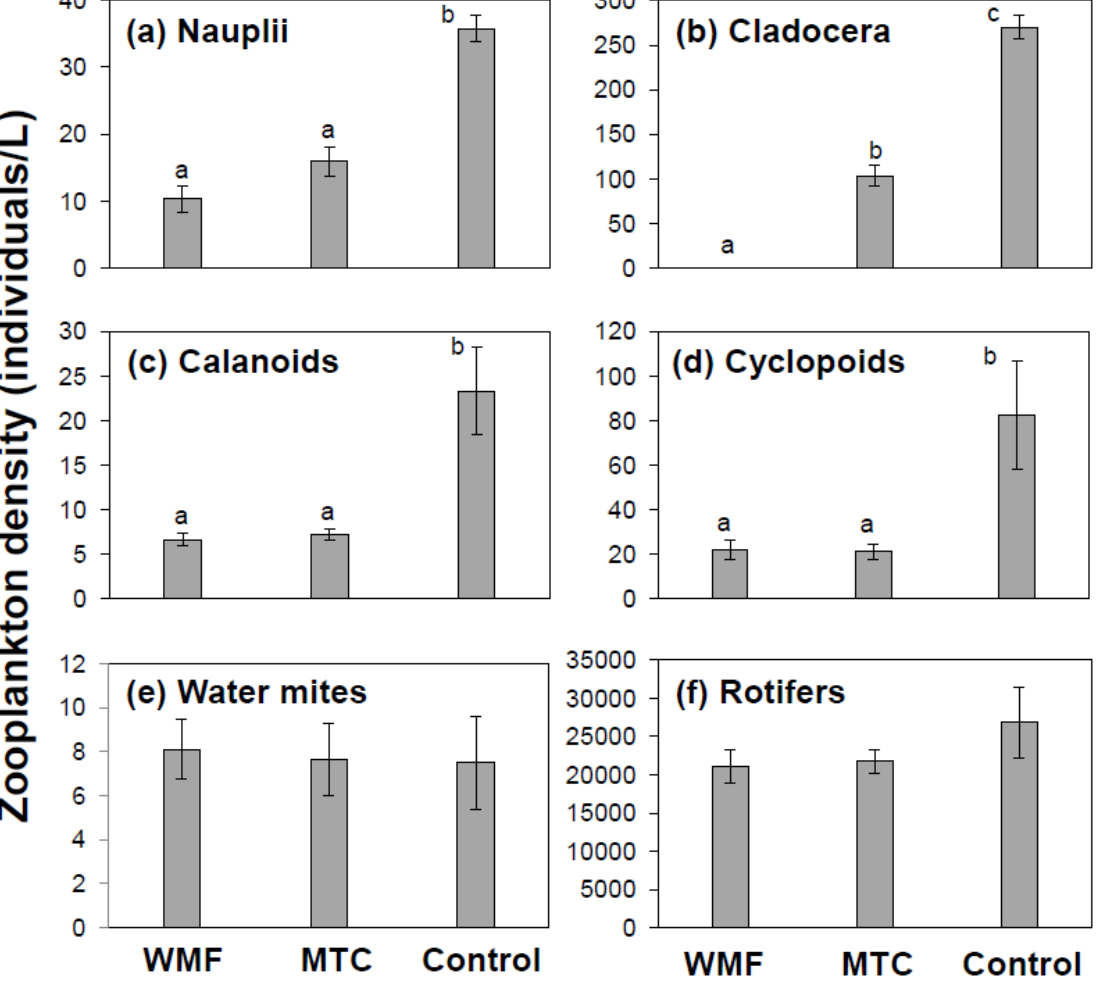
Figure 1. Differences in mean density of major zooplankton taxa among treatments. Significant differences of mean densities were observed for ( a ) crustacean nauplii ( X 2 3 = 12.67; p = 0.002); ( b ) cladocera ( X 2 3 = 21.47; p < 0.001); ( c ) calanoid copepods ( X 2 3 = 11.76; p = 0.003); and ( d ) cyclopoid copepods ( X 2 3 = 9.80; p = 0.007). No significant treatment differences were observed for ( e ) water mites and ( f ) rotifers. Treatment codes: WMF = allopatric mosquitofish, MTC = allopatric tui chubs, and Control =fishless control. Error bars are one standard error. Similar upper case letters on top of bars indicate non- significant pair-wise comparisons after Bonferroni